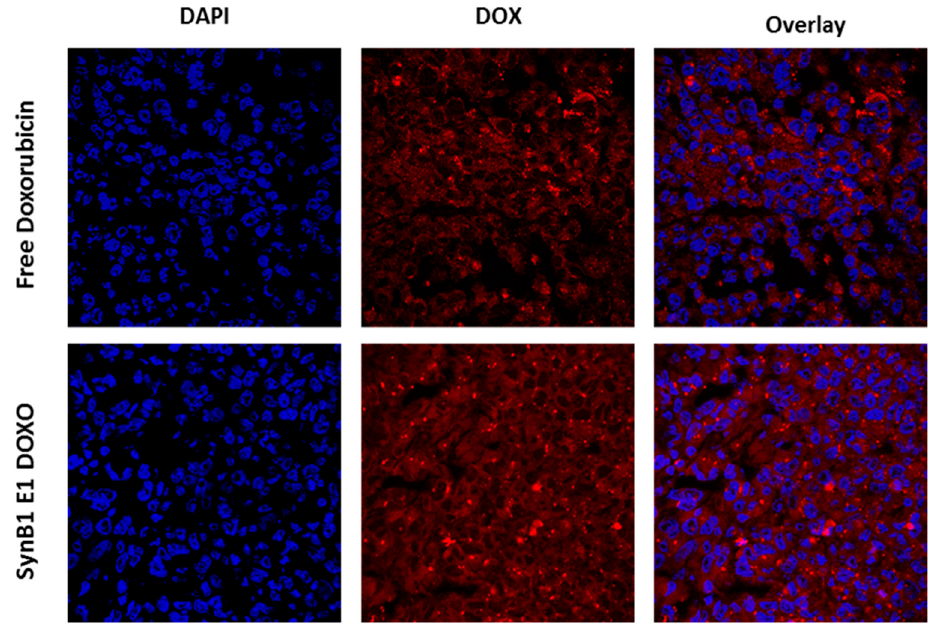
Figure 6. Confocal images of breast cancer tumor sections. Distribution of free doxorubicin and Dox delivered by SynB1-ELP-DOXO. Tumor tissue sections were harvested from tumor bearing nude mice 2 h after intravenous injection of Dox or SynB1-ELP-DOXO. Representative images show Dox fluorescence (red) after staining cell nuclei with DAPI (blue) and viewed using a 20× magnification objective.